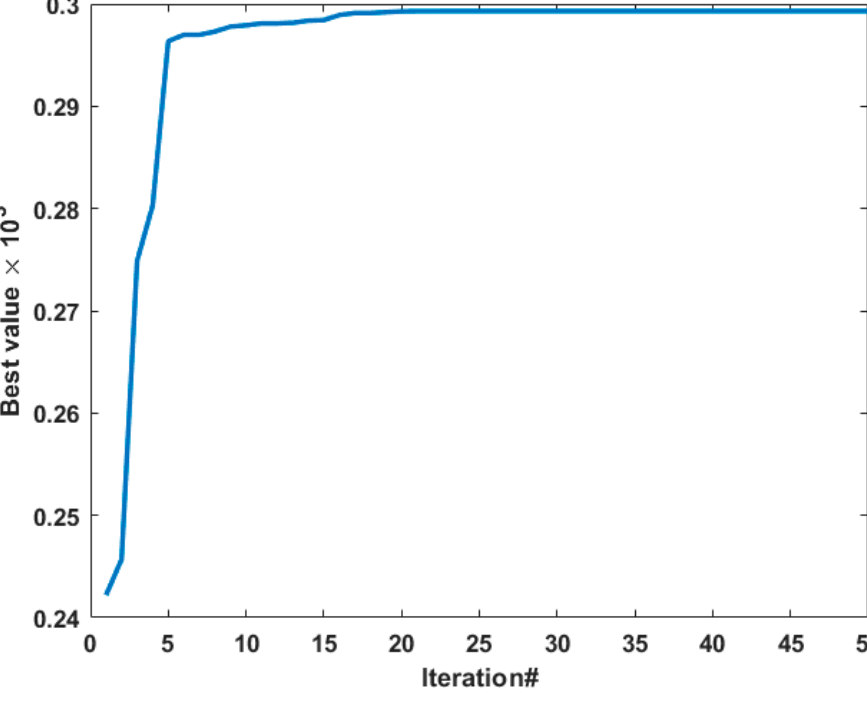
Table 1. Performance comparison between experimental, ANOVA, and proposed ANFIS–PSO strategies.